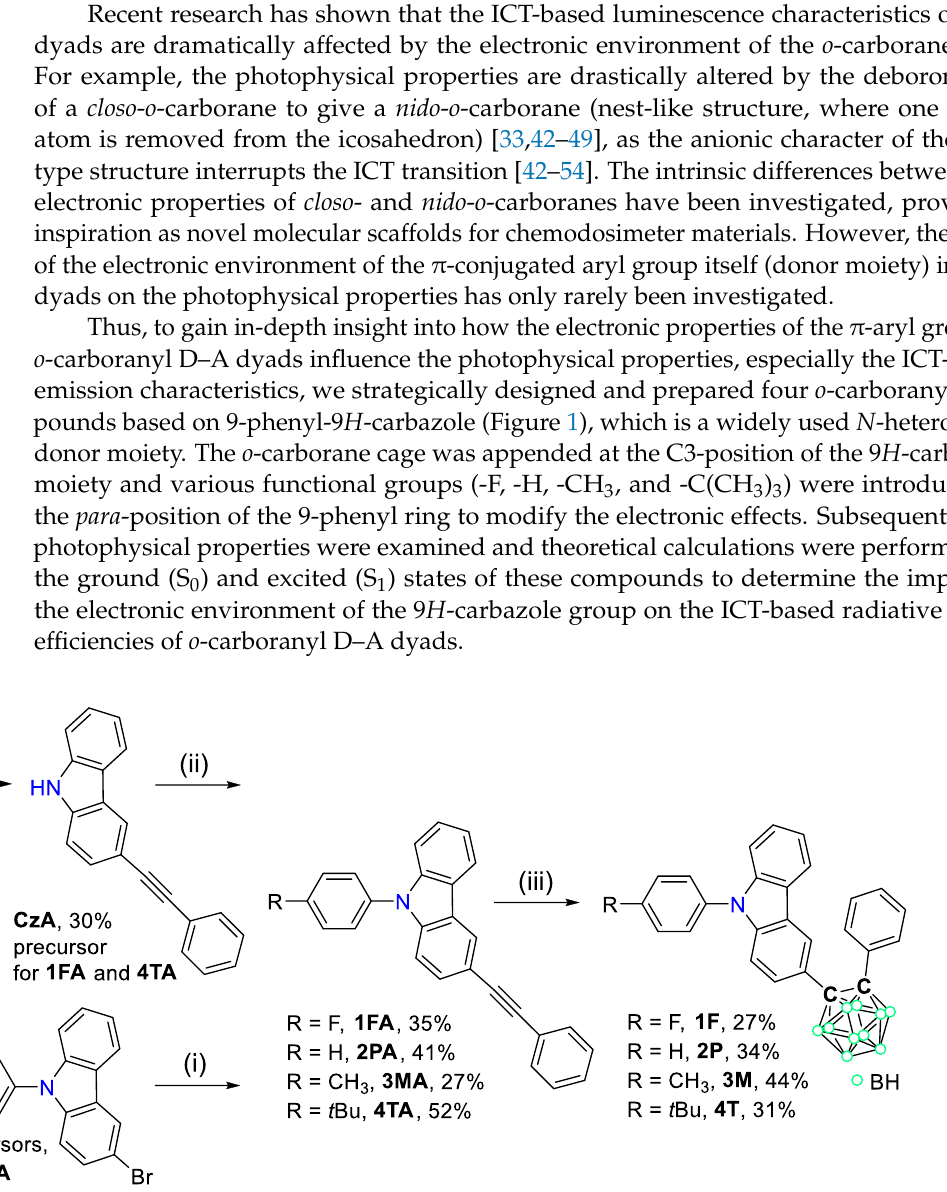
Figure 2. X-ray crystal structures for 1F (left) and 4T (right) (50% thermal ellipsoids with H atoms omitted for clarity). 3.2. Experimental and Theoretical Analysis of Photophysical Properties The photophysical properties of the 9-phenyl-9 H -carbazole-based o -carboranyl com- pounds ( 1F , 2P , 3M , and 4T ) were investigated using UV/Vis-absorption and PL spectros- copies (Figure 3 and Table 1). All the compounds exhibited a low absorption band cen- tered at λ abs = ~329 nm with a broad shoulder extending to 350 nm. This absorption band was mainly attributed to the spin-allowed π–π* local excitation (LE) transition of the 9- phenyl-9 H -carbazole moiety, as the parent compound (9-phenyl-9 H -carbazole) exhibited a similar major absorption band in the region of λ abs = 327‒337 nm (Figure S16). However, TD-DFT calculations for the S 0 state of the o -carboranyl compounds suggested that this band could also be attributed to a weak ICT transition from the carbazole moiety to the o - carborane cage and terminal phenyl ring (vide infra). Furthermore, a strong absorption peak centered at λ abs = 279 nm was observed in the spectrum of each o -carboranyl com- pound, which originates from the π–π* transition of the carbazole group, as 9-phenyl-9 H - carbazole showed an absorption maximum at λ abs = 284 nm (Figure S16). To obtain insight into the origin of the electronic transitions for 1F , 2P , 3M , and 4T , TD-DFT calculations were performed on each S 0 -optimized structure [56]. These calcula- tions were based on the solid-state molecular structure of 1F and an IEFPCM was used to include the effect of THF as the solvent [57]. The computational results for the S 0 -opti- mized structures revealed that the major low-energy electronic transitions were mainly associated with transitions from the highest occupied molecular orbital (HOMO) to the